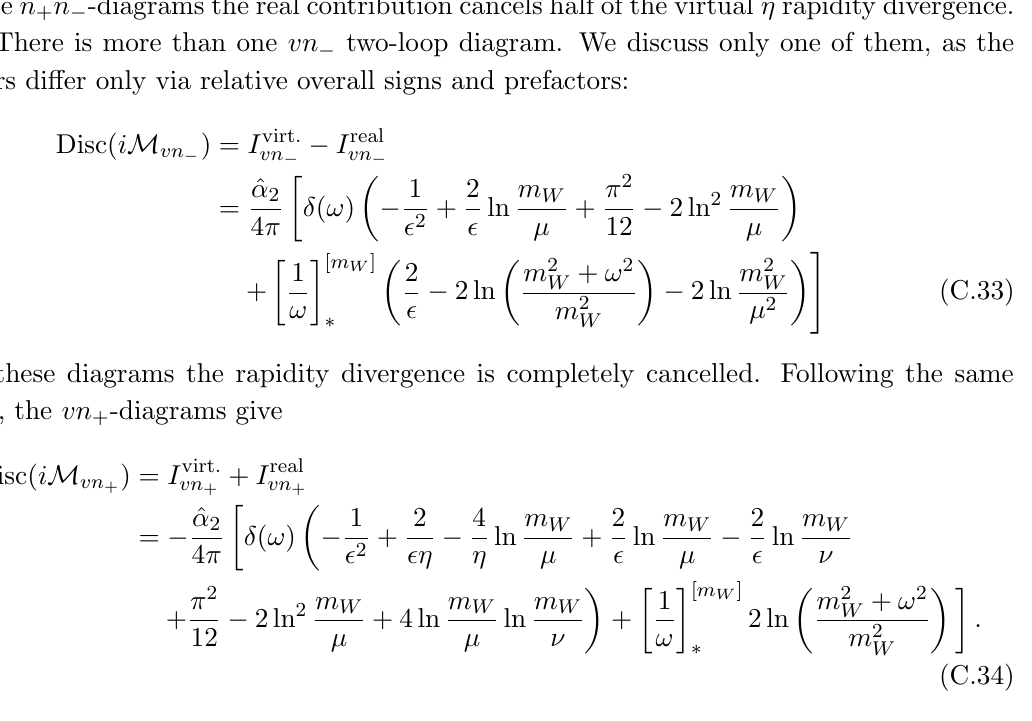
n (cid:0) -two-loop +